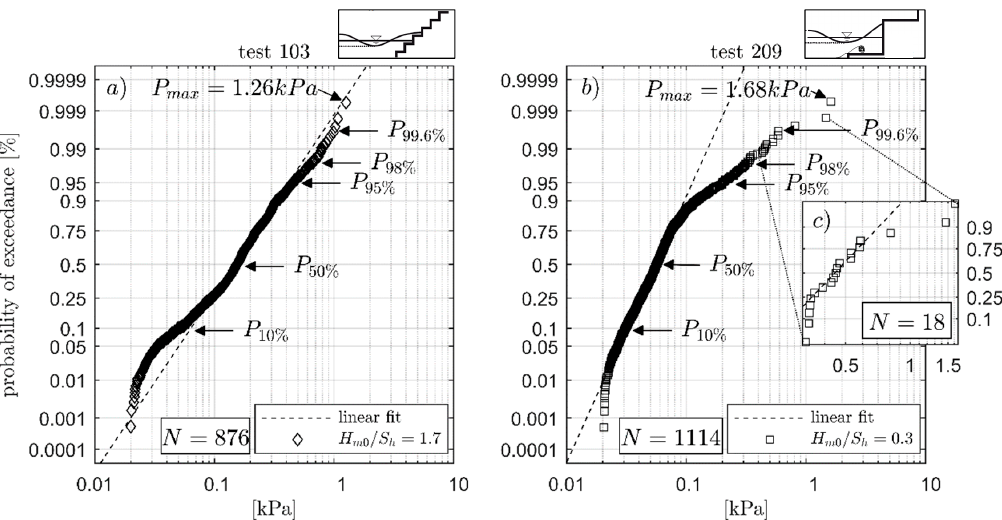
Figure 4. Recorded pressure impacts and log-normal probability distributions of the maximum impact pressures for ( a ) small step heights (test 103, pressure sensor P1 , H m 0 / S h = 1.7) and ( b ) large step heights (test 209, pressure sensor P2 , H m 0 / S h = 0.3). ( c ) Gives a detail of the log-normal probability